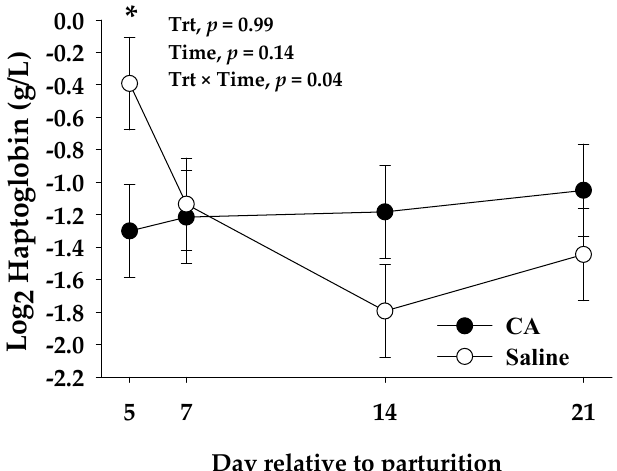
Figure 2. Residual effects of carnosic acid (CA) or saline intravenous infusions on blood biomarkers from 5 to 21 d relative to parturition for haptoglobin. Mean separations between treatments at a given time point were evaluated at a treatment × time interaction ( p ≤ 0.10), and differences (*) were declared at p ≤ 0.05. Values are means and the standard errors are represented by vertical bars.